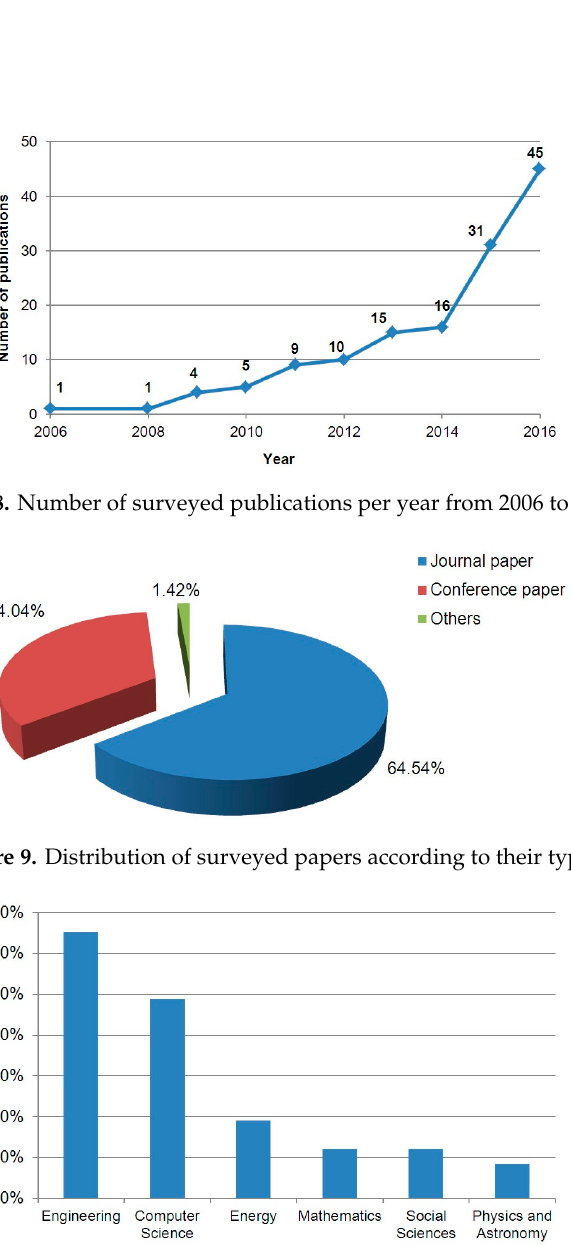
Figure 10. Distribution of surveyed publications between the top six subject areas.